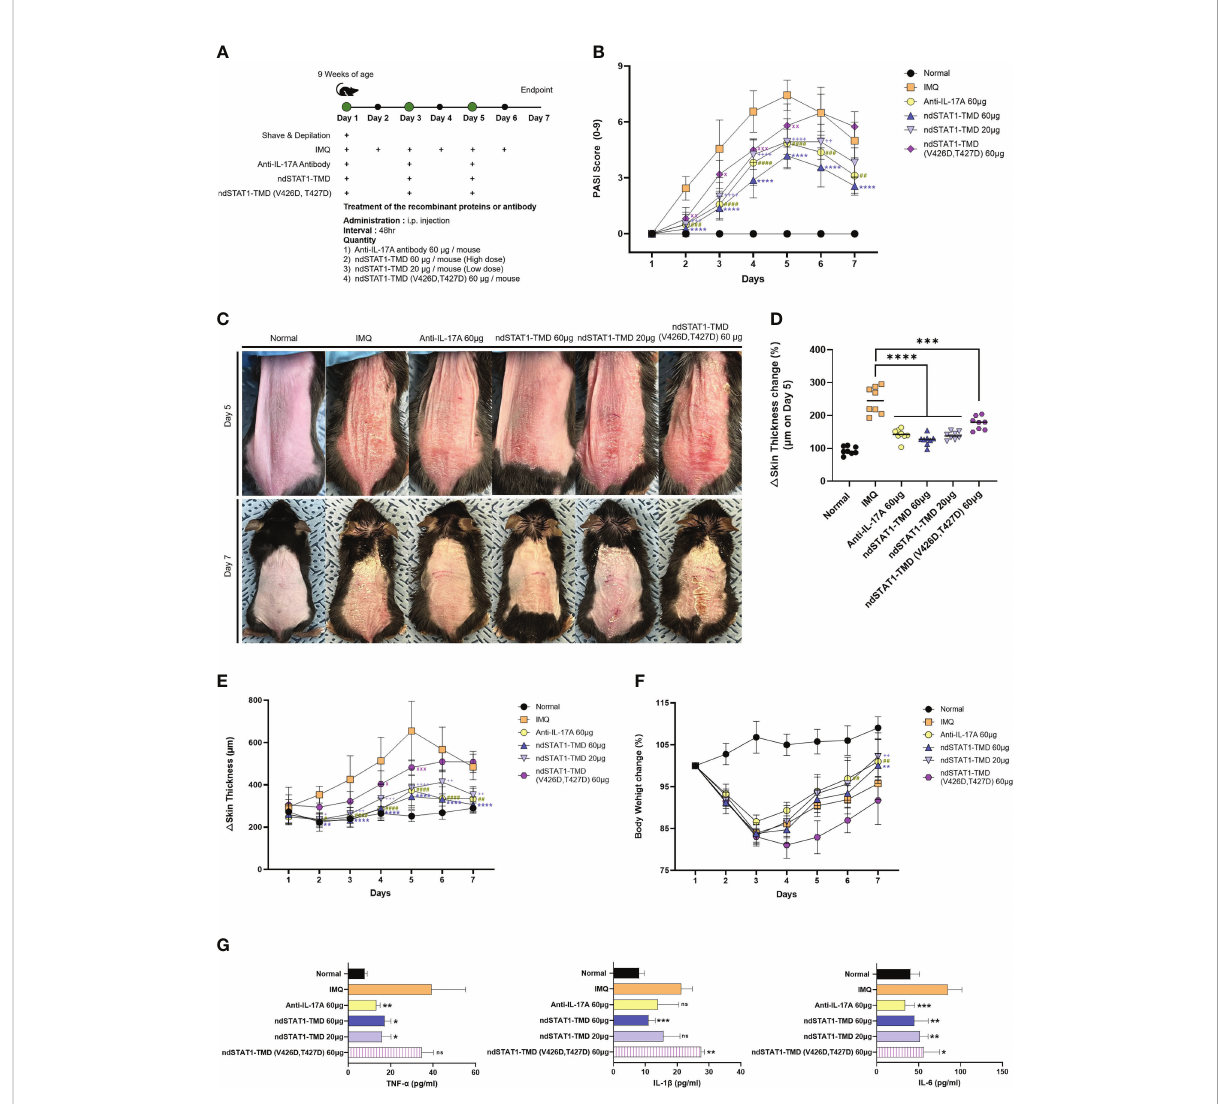
FIGURE 4 ndSTAT1-TMD treatment attenuates the disease severity of the IMQ-induces psoriasis. (A) The treatment scheme of 5% IMQ-induced psoriasis mice with PBS (IMQ group), anti-IL-17A antibody (60 m g/mouse), ndSTAT1-TMD (20 m g/mouse or 60 m g/mouse), or ndSTAT1-TMD (V426D, T427D) (60 m g/mouse). (B) PASI scoring plots in the back skin of each group from (A) for disease progression. (C) Representative images of mice back skin damage from (A) on day 5 (above panel) and day 7 (below panel). (D) Change of back skin thickness within each group from (A) of day 5, calculated based on the thickness of day 1. The graph is represented as mean ± SEM (n=8), and Student ’ s t-test was used for statistical analysis. ***p<0.001, and ****p<0.0001. (E) Back skin thickness of mice in each treated group. (F) Body weight change of each group. (G) The level of pro-in fl ammatory cytokines (TNF- a , IL-1 b , or IL-6) from the serum of the mice in each group was measured by ELISA. The experiments in the psoriasis model were independently performed twice times. The graphs are represented as mean ± SEM (n=5), and the statistical analysis was examined using Student ’ s t-test. ns, not signi fi cant, *p<0.05, **p<0.01, and ***p<0.001. The graphs in (B, E, F) are represented as mean ± SEM (n=8), and the statistical analysis was also examined using ANOVA analysis followed by Dunnett ’ s multiple comparison test. #,+, x p<0.05; **,##,++,xx p<0.01; ###,+++,xxx p<0.001; ****,####,++++ p<0.0001. * IMQ and ndSTAT1-TMD 60 m g, # IMQ and anti-IL-17A antibody 60 m g, + IMQ and ndSTAT1-TMD 20 m g, x IMQ and ndSTAT1-TMD (V426D, T427D) 60 m